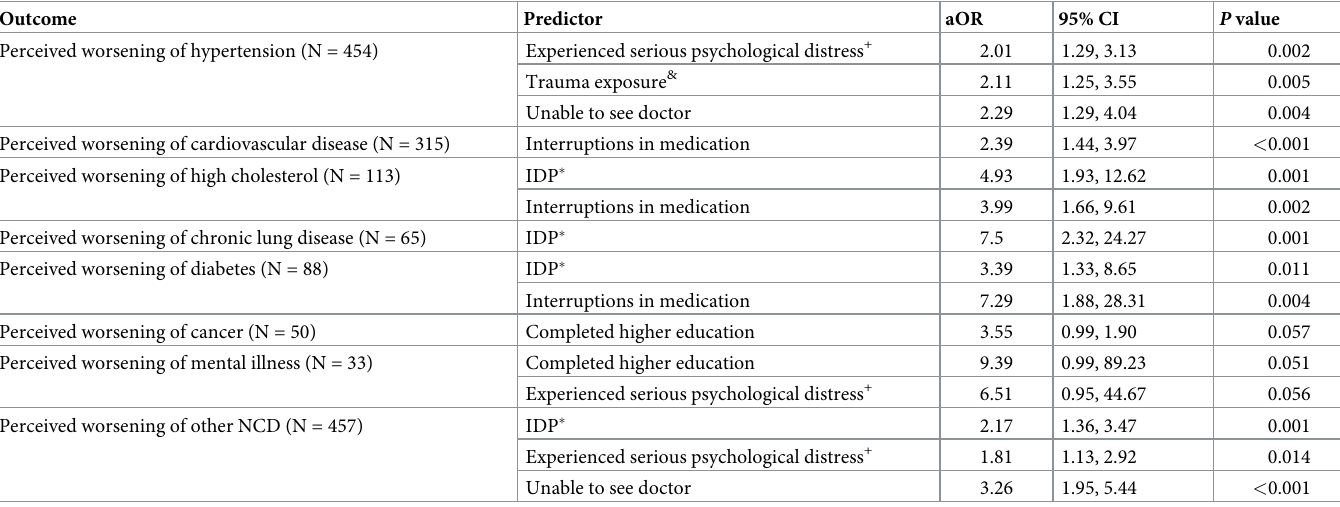
Table 5. Risk factors associated in multivariate analysis with perceived worsening of noncommunicable